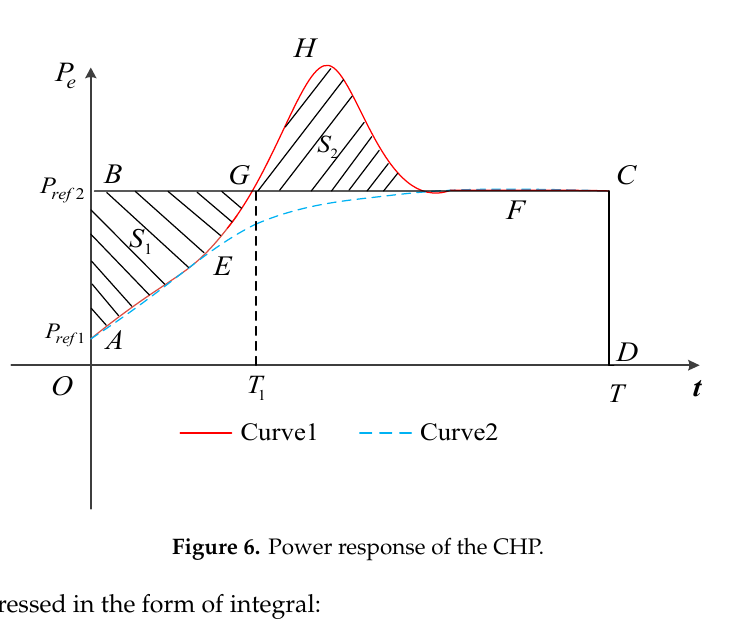
Figure 6. Power response of the CHP.